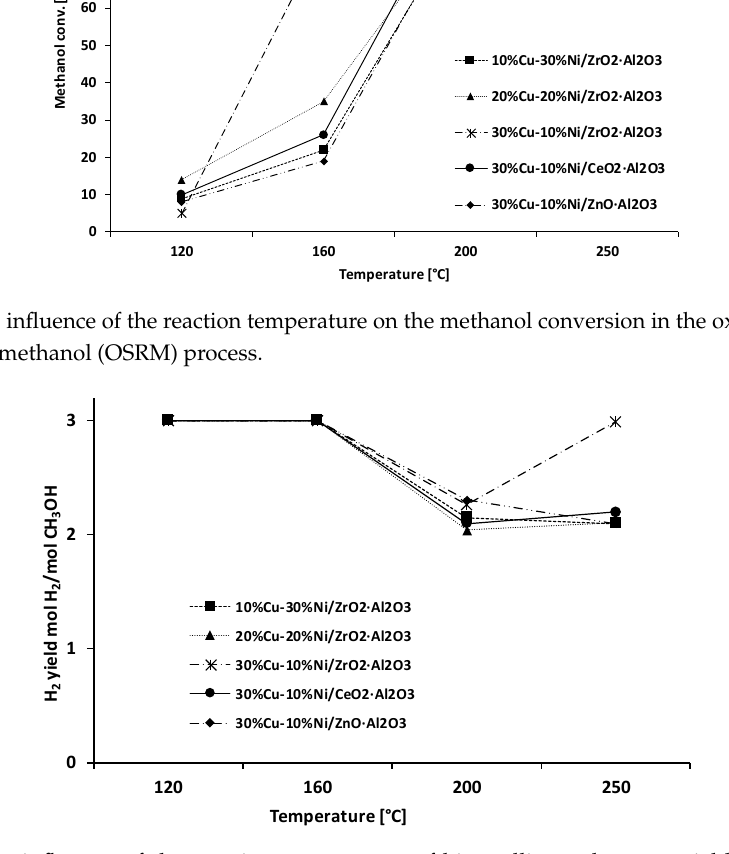
Figure 2. The influence of the reaction temperature of bimetallic catalysts on yield of hydrogen production in the OSRM process.